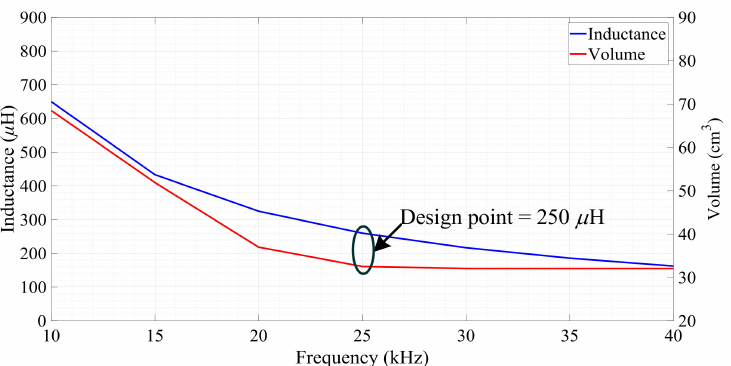
Figure 6. Relation of inductance and volume according to switching frequency.